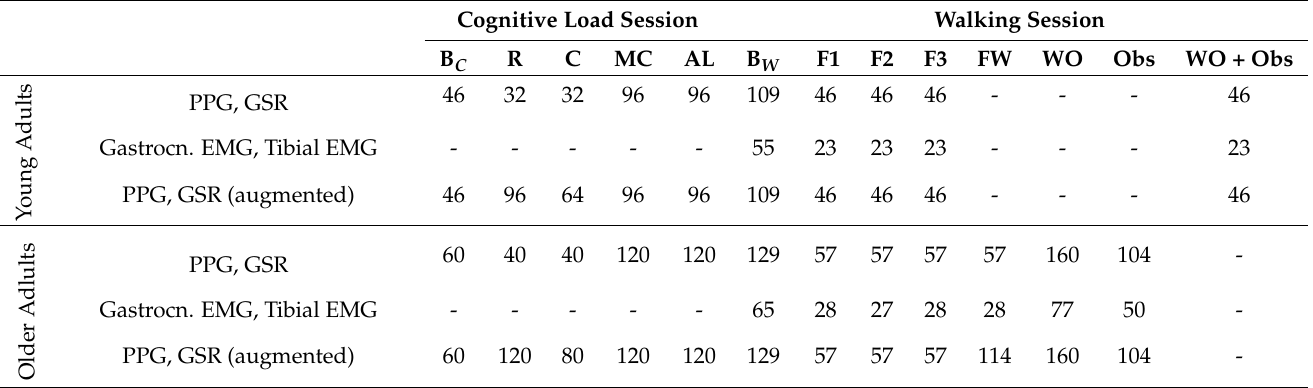
Table 1. Number of instances for each task in cognitive load session (first 5 columns) and in walking session (last 8 columns). For each subject group (Young Adults and Older Adults), the first row is related to signals collected using the Shimmer3 GSR+ unit (PPG and GSR) while the second row refers to signals acquired using the Shimmer3 EMG (gastrocnemius muscle EMG and tibial muscle EMG). In the third row is reported the cardinality involved during the classification tasks. In particular, for the reading, comprehension and free walk tasks are reported the cardinality resulting from data augmentation. The analyzed tasks have been referred to according to the following coding: B C = baseline task collected during the cognitive load session, R = reading task, C = calculation task, AL = audio listening task, B W = baseline task collected during the walking session, F1 =